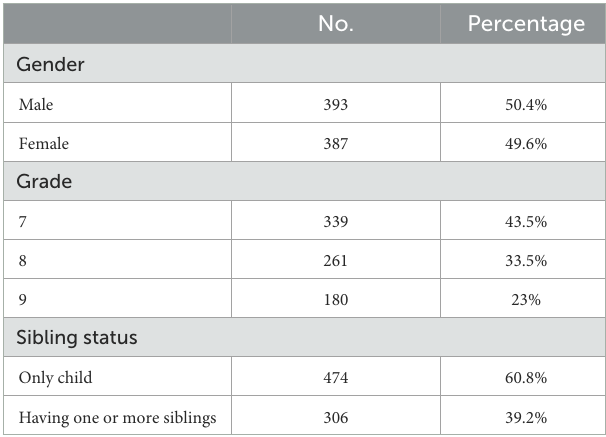
TABLE 1 Demographic characteristics of the